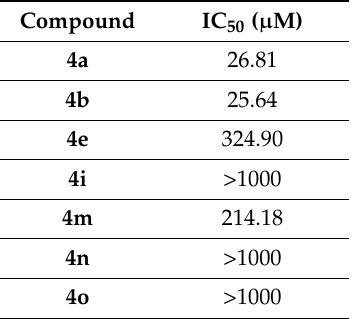
Table 2. IC 50 of selected derivatives against a murine fibroblast healthy cell line (NIH3T3).